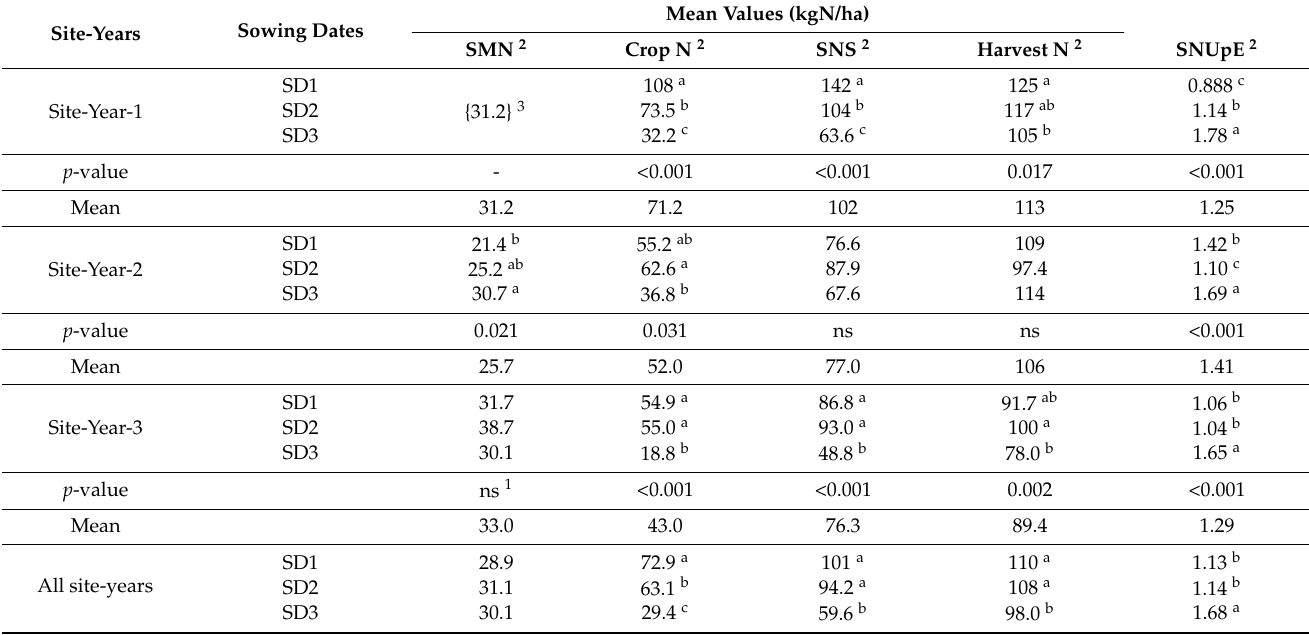
Table 4. Effect of sowing date and site-year interactions on early spring measurements (SMN, crop